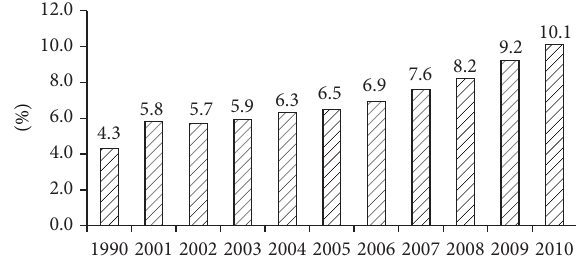
Figure 1: Percentage of renewables in energy supply in OECD Europe, 1900–2010. Source: Factbook 2012 - ISSN - OECD 2012.